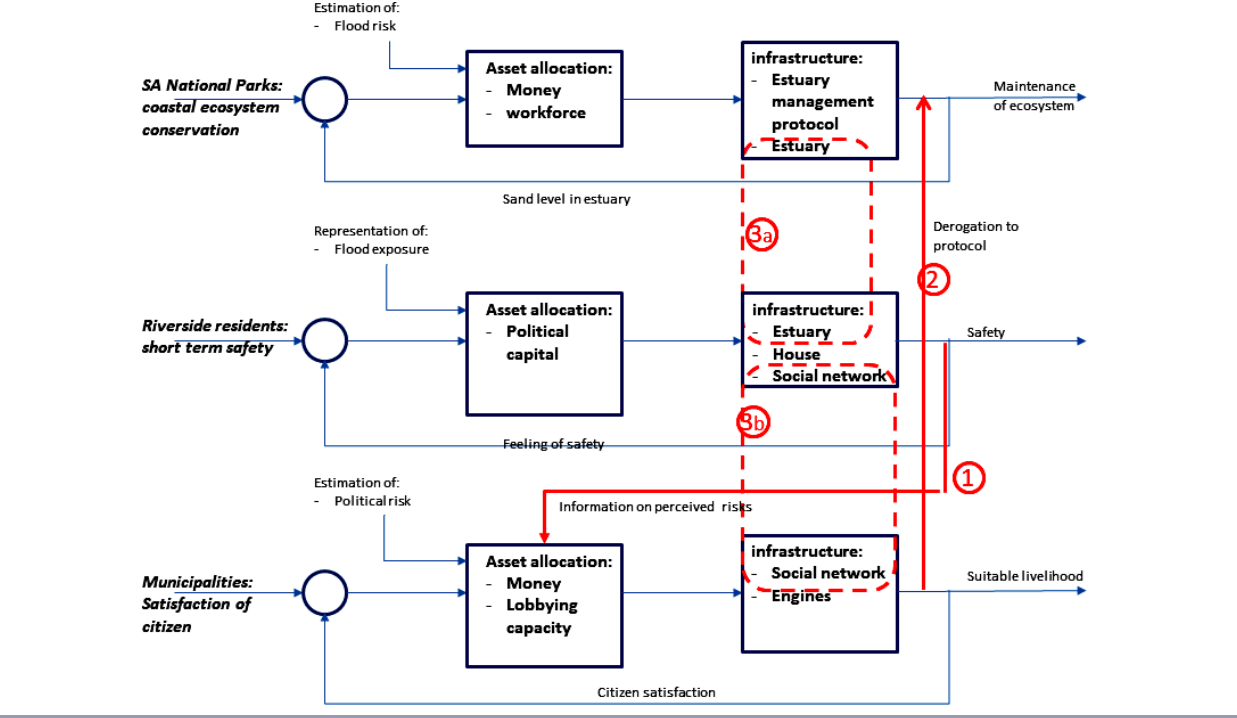
Fig. 4 . Vulnerability transfers observed in estuary breaching in South